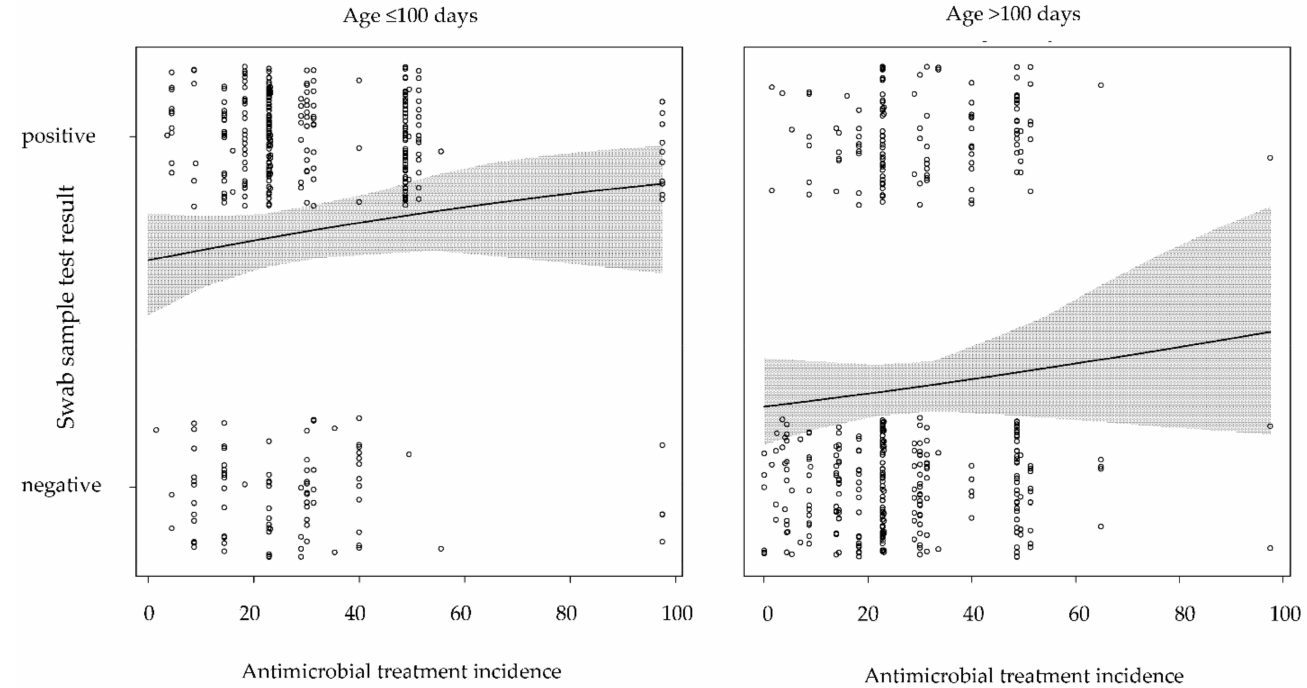
Figure 2. Probability of positive nasopharyngeal swab sample of bovine coronavirus, dependent on antimicrobial treatment incidence and age. Table 7. Prevalence of respiratory viruses 1 and bacteria 2 in 384 3 deep nasopharyngeal swab samples from calves from 12 Swiss veal calf farms. Only bacteria found in combination in more than five 5 observations are presented. Organism